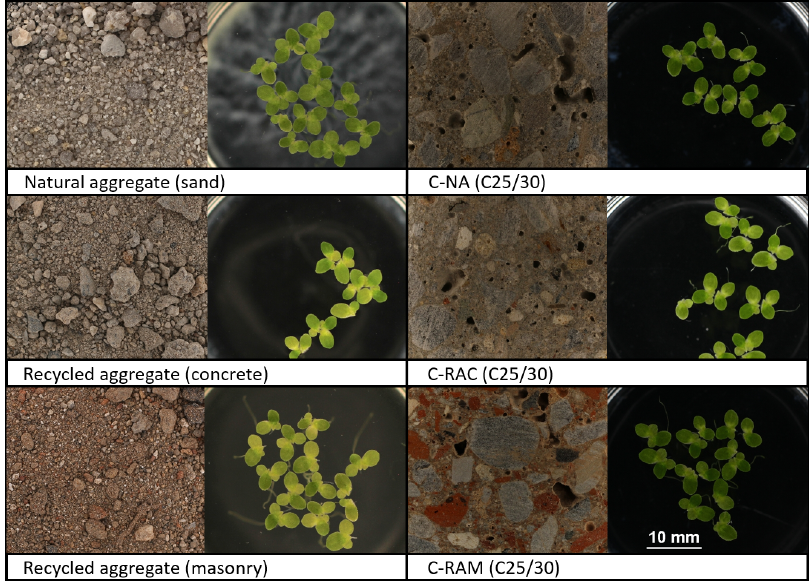
Figure 3. Example of Lemna minor semichronic toxicity test performed with 80 % leachates of natural and recycled aggregates fraction 0–4 mm (left) and 80 % leachates of concrete mixes (C25/30) based on the relevant aggregates (right). C-NA – reference concrete, C-RAC – concrete containing concrete-derived recycled aggregate, C-RAM – concrete containing masonry-derived recycled